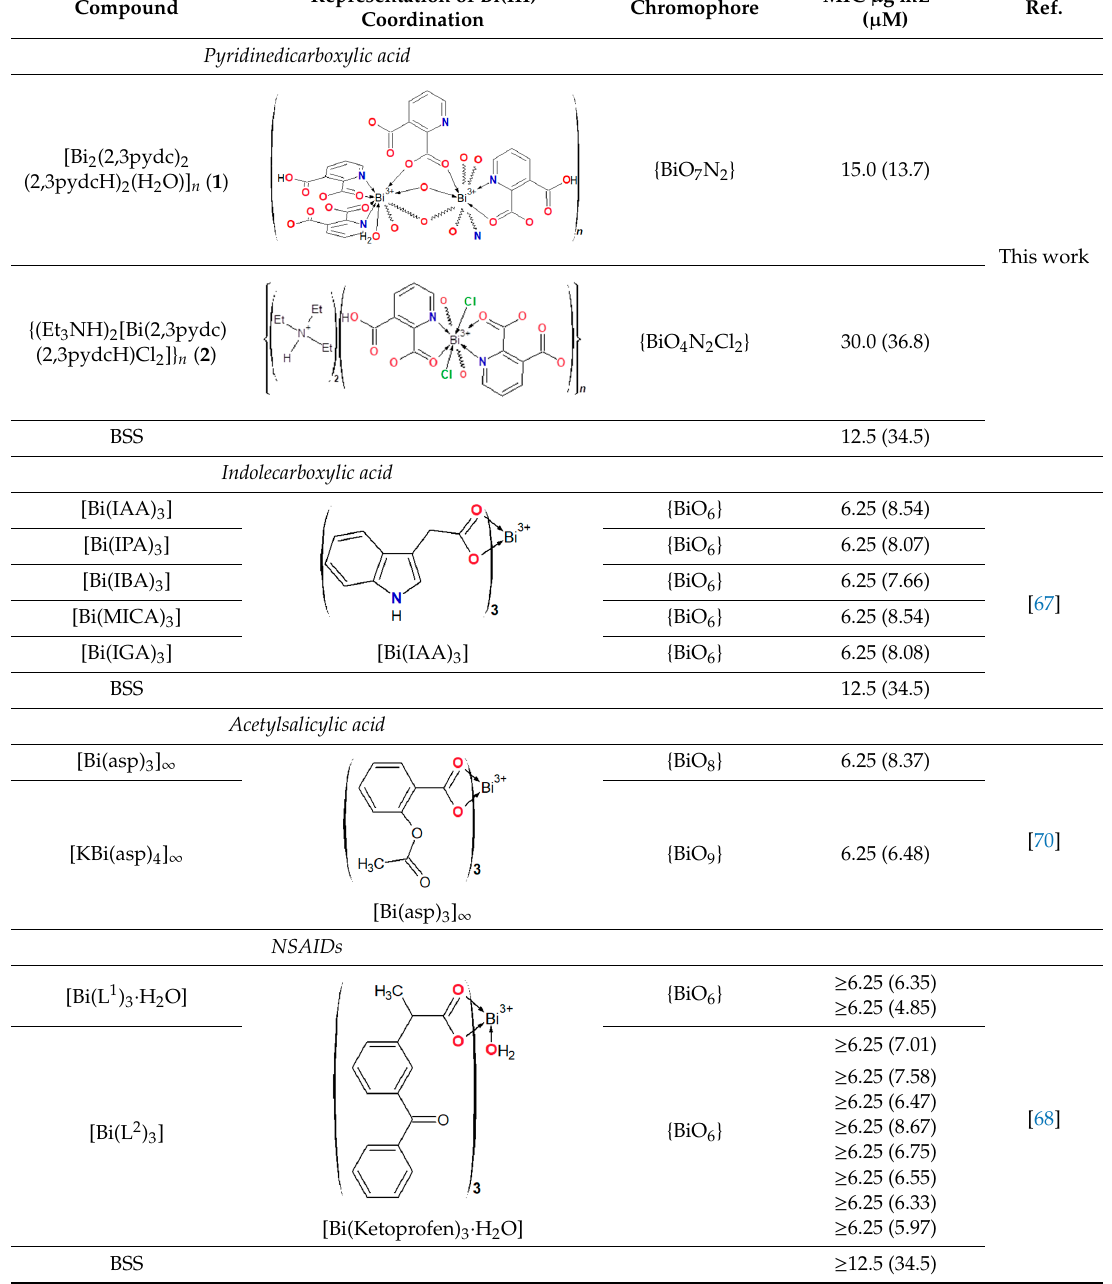
Table 5. Antibacterial activity of Bi(III) carboxylate complexes against Helicobacter pylori strain 26695. Compound